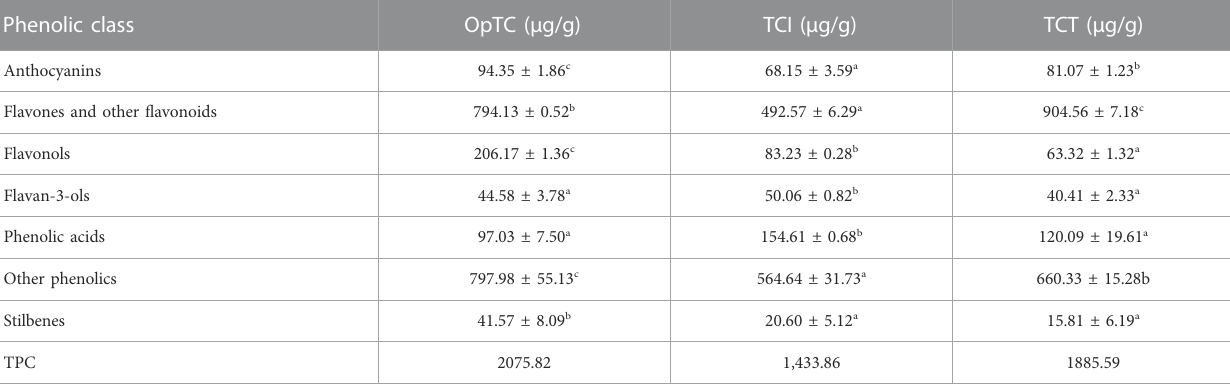
TABLE 1 Semi-quantitative analysis on the total phenolic content in the different T. comosus extracts considering the main phenolic subclasses, namely anthocyanins, fl avones and other fl avonoids, fl avonols, fl avan-3-ols, phenolic acids, other phenolics, and stilbenes. Results are expressed as mean value (µg Equivalents/g dry matter) ± standard deviation ( n = 3). TPC = total phenolic content; Eq. = Equivalents. Superscript letters within each row indicate signi fi cant differences (Duncan ’ s test; p -value <